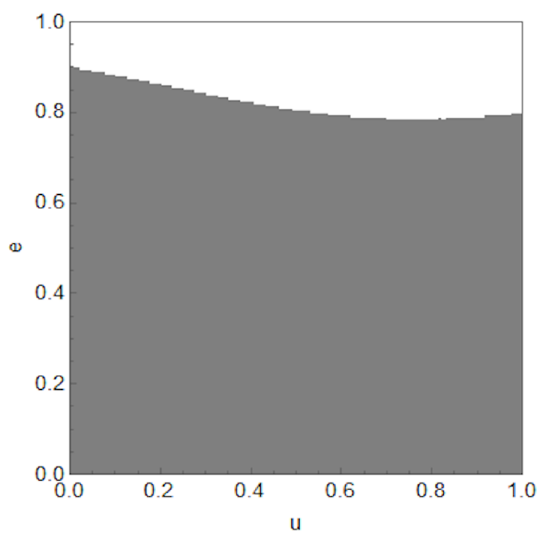
Figure 6. Phase diagram in d = 4 : shaded regions indicate values of e = ( κ − κ − ) / ( κ + − κ 1 ) and u = L 2 /L 1 for which a connected solution exists and the vacuum energy is negative, while unshaded regions indicate values for which a connected solution does not exist and the vacuum energy is